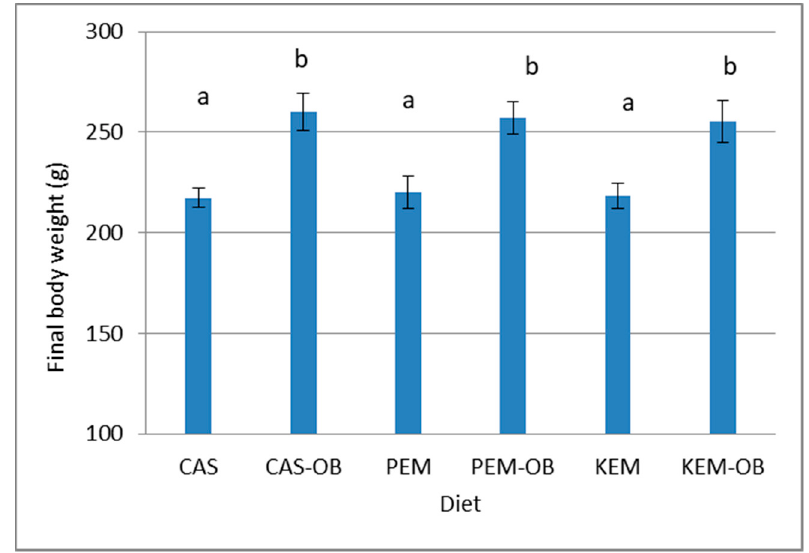
Figure 1. Final body weight of rats fed casein or casein + extruded mix diets either obesogenic or not. CAS, casein diet; KEM, kidney bean ( Phaseolus vulgaris ) extruded mix diet; PEM, pea ( Pisum sativum ) extruded mix diet. Diets CAS-OB, KEM-OB, and PEM-OB were the same diets described above with added 5.48 g / day condensed milk. Values are means ( n = 12) with their standard error of the mean (SEM) in bars. ab Means with different superscript differ ( p < 0.01).